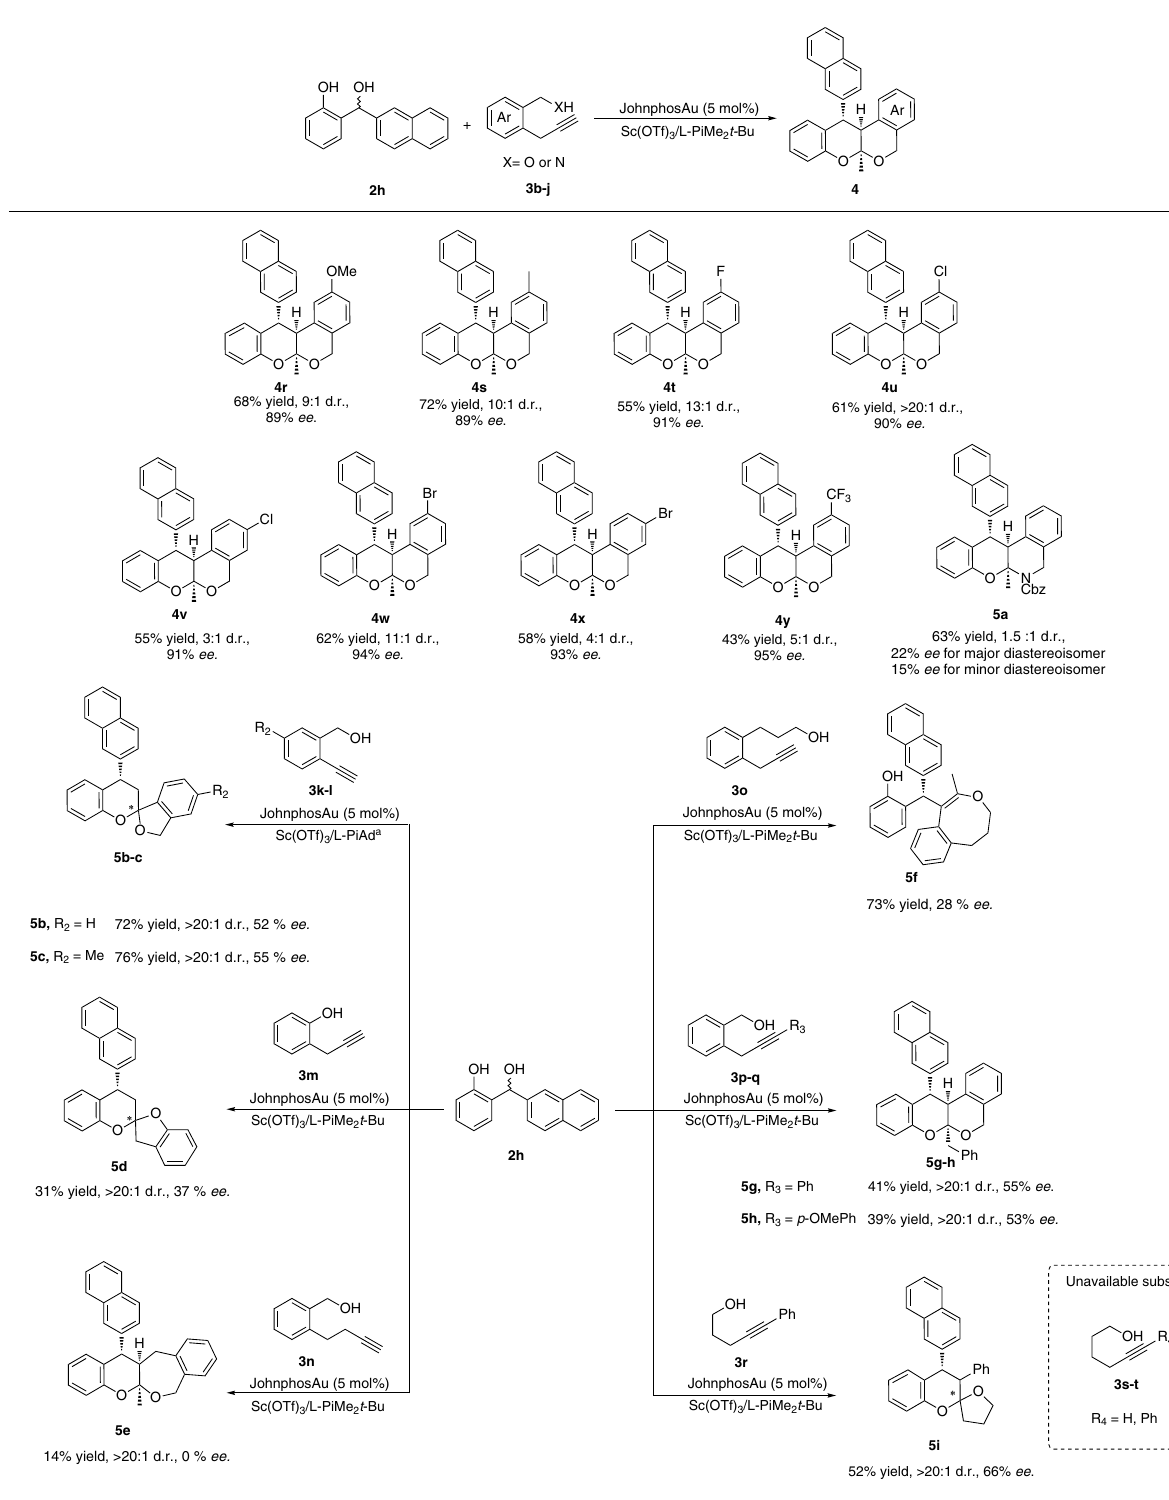
structure of tetracyclic isochroman natural product, 8r (R = H) as a precursor of o -QM was tested in the asymmetric reaction with 2a , but no product was obtained. Unexpectedly, TMS substituted ortho -hydroxybenzyl alcohol 8s gave the product 9a with the